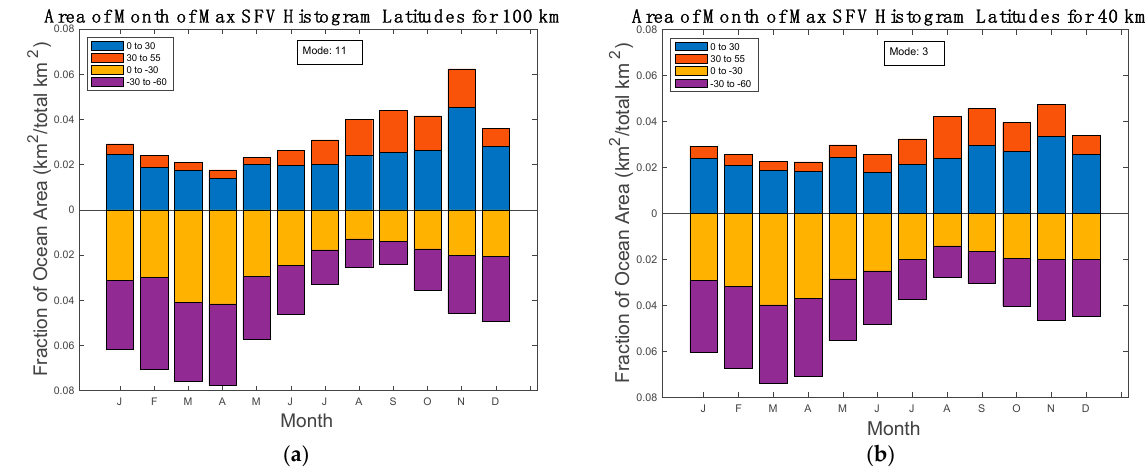
Figure 6. Distribution of SFV evaluation grid points (e.g., yellow circle in Figure 1) by month. ( a ) At each grid point, the month is found where that grid point is at its maximum SFV. The normalized area (area of the 2° × 2° boxes analyzed divided by the total area of the ocean) is then summed for a given month for 100 km footprint. Yellow and purple bars are southern hemisphere, 0 to 30° S and 30° S to 60° S, respectively, increasing downward. Blue and red bars are northern, 0 to 30° N and 30° N to 55° N, respectively. The box shows the mode, or month with the most locations—November in this case. ( b ) Same but for 40 km footprint.